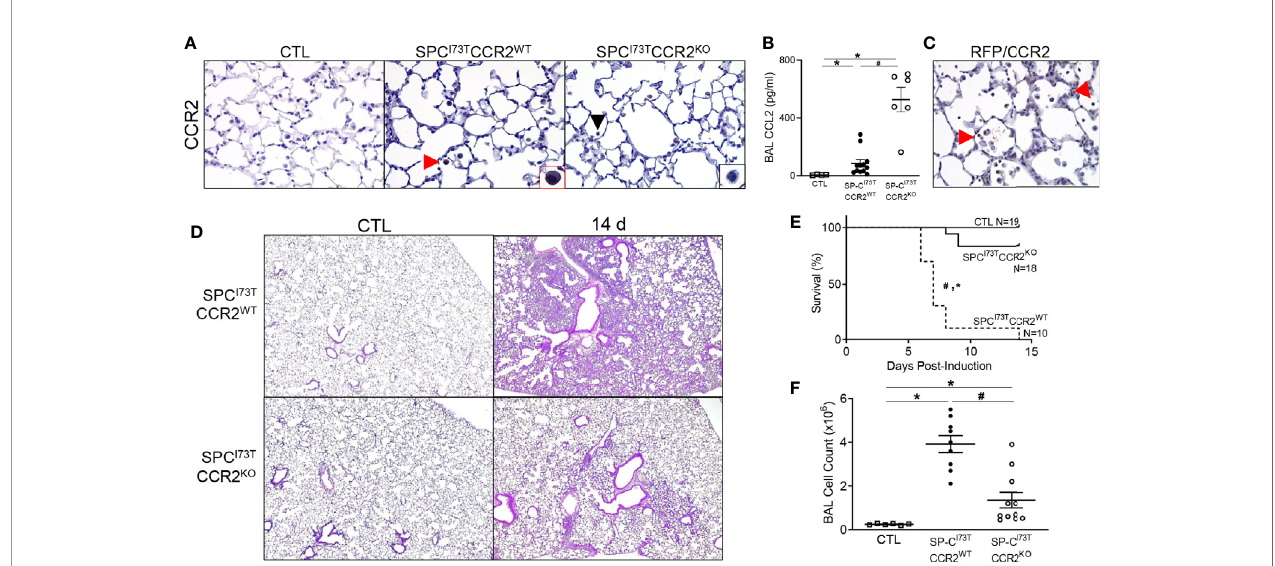
FIGURE 5 | Effects of genetic CCR2 monocyte ablation on lung injury, survival and in fl ammation following SP-C I73T mutant induced injury. (A) Immunohistochemical analysis of control (CTL, tamoxifen treated SP-C WT or oil treated SP-C I73T mice), SP-C I73T CCR2 WT and SP-C I73T CCR2 KO lung sections were immunostained with antibody to CCR2. Red arrowheads indicate myeloid cells staining for CCR2. Insets show magni fi ed cells; box color matches that of respective arrowhead. Black arrowheads indicate negative CCR2 staining in mononuclear cells in SP-C I73T CCR2 KO cohorts. Images shown are representative of 3-5 animals per group. Magni fi cation: 400x. (B) CCL2 ELISA of BAL fl uid from control (CTL, tamoxifen treated SP-C WT or oil treated SP-C I73T mice), SP-C I73T CCR2 WT and SP-C I73T CCR2 KO mice 14 d following tamoxifen administration. Data are represented as mean ± SEM (N=4-13). (C) Histochemical analysis of SP-C I73T CCR2 RFP lung sections 14 d post injury immunostained with antibody to RFP/CCR2. Arrowheads indicate cells expressing the receptor (D) Hematoxylin & Eosin stained sections of control (CTL, tamoxifen treated SP-C WT , CCR2 KO , or oil treated SP-C I73T mice), SP-C I73T CCR2 WT and SP-C I73T CCR2 KO lungs 14 d post injury. Magni fi cation: 400x. (E) Kaplan – Meier survival analysis from control (tamoxifen treated SP-C WT or oil treated SP-C I73T mice) SP-C I73T CCR2 WT and SP-C I73T CCR2 KO . Mice found dead or displaying body weight loss equating >25% of stating weigh for 2 consecutive days. *p<0.05 compared to control mice; # p<0.05 compared to SP-C I73T CCR2 WT mice by Log- Sum (Mantel-Cox) Rank test. (F) BAL fl uid cell counts from control (CTL, tamoxifen treated SP-C WT or oil treated SP-C I73T mice), SP-C I73T CCR2 WT and SP- C I73T CCR2 KO (N =6-11) 14 d following SP-C I73T induced lung injury. Data are represented as mean ± SEM. *p<0.05 compared to control mice; # p<0.05 compared